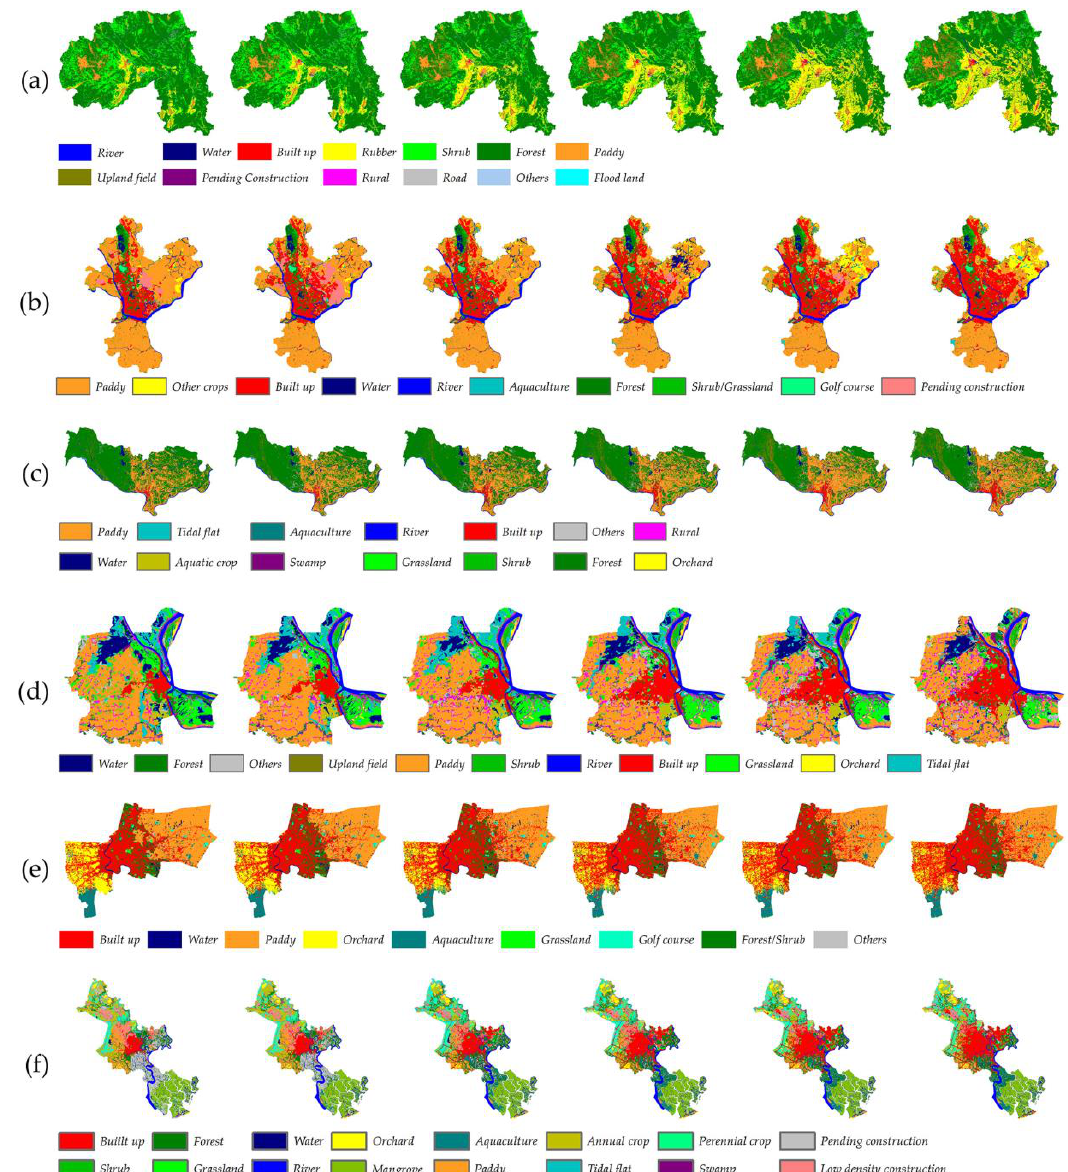
Figure 4. Land use maps of typical cities in the GMS in 1990, 1995, 2000, 2005, 2010, 2015, respectively (from left to right): ( a ) Xishuangbanna; ( b ) Yangon; ( c ) Vientiane; ( d ) Phnom Penh; ( e ) Bangkok; and ( f ) Ho Chi Minh City.